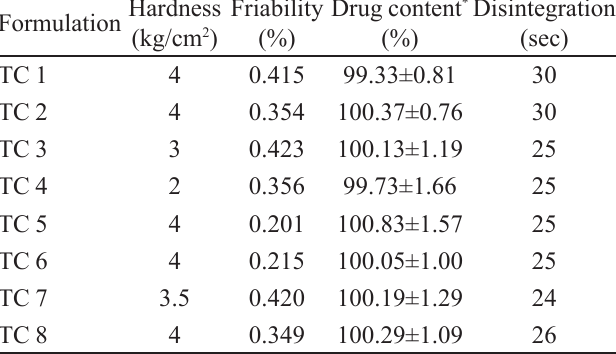
TABLE IV - Evaluation of physico-chemical parameters of core